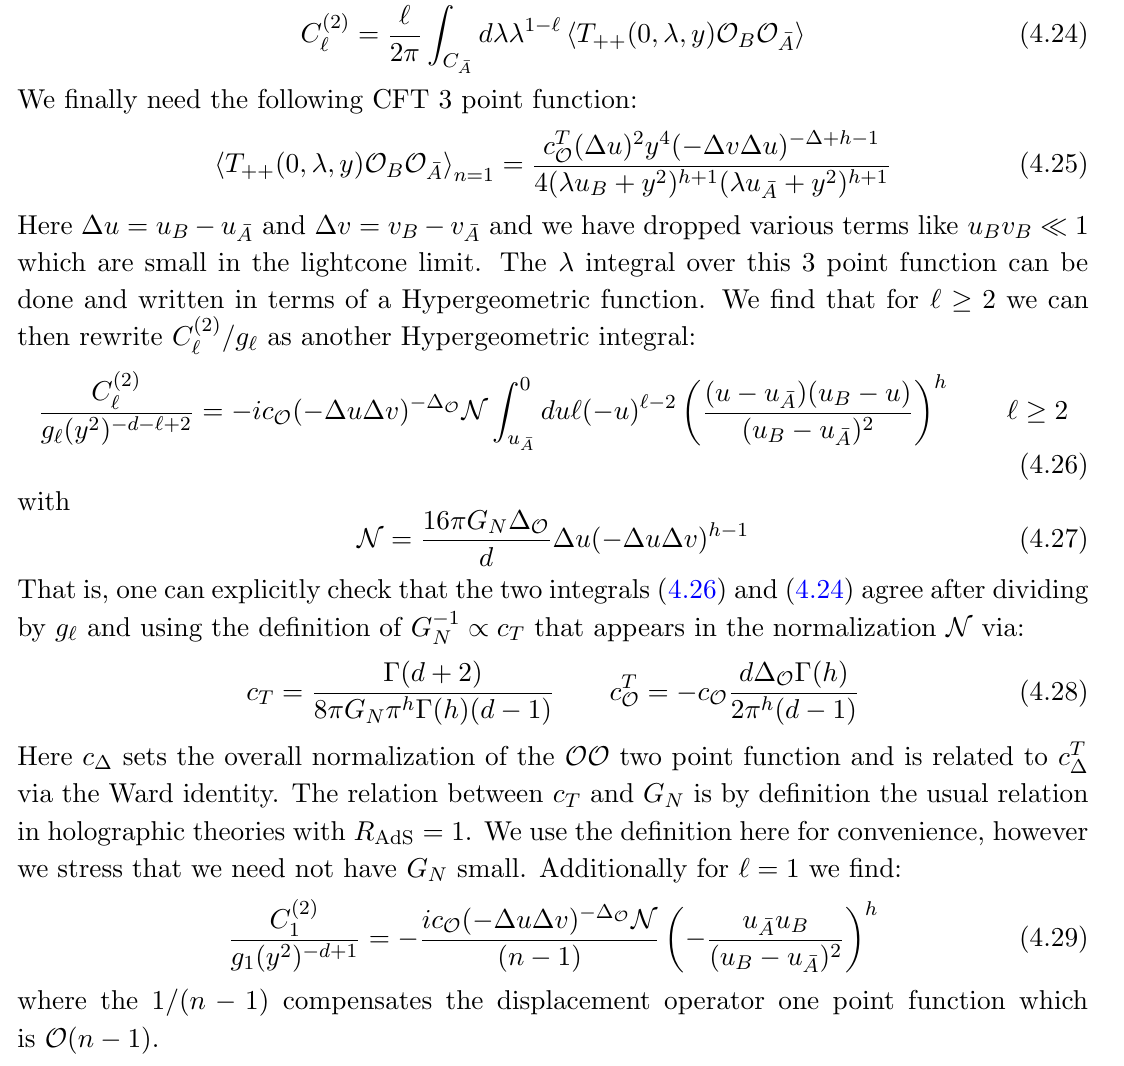
in (4.20) and (4.23) (cid:30)